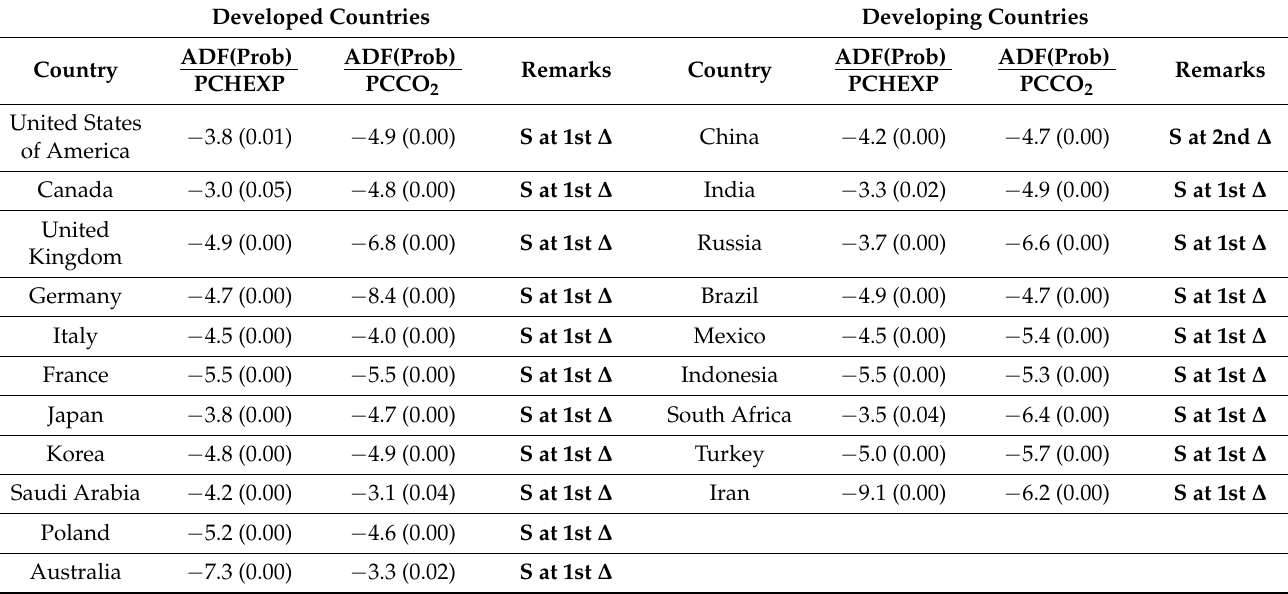
Note: PCHEXP indicates per capita health expenditure and PCCO 2 indicates per capita CO 2 emissions. The results are derived under both ADF and PP tests, but the values are shown for ADF only to avoid space problems. ‘ ∆ ’ and ‘ S ’ stand for difference and stationary series